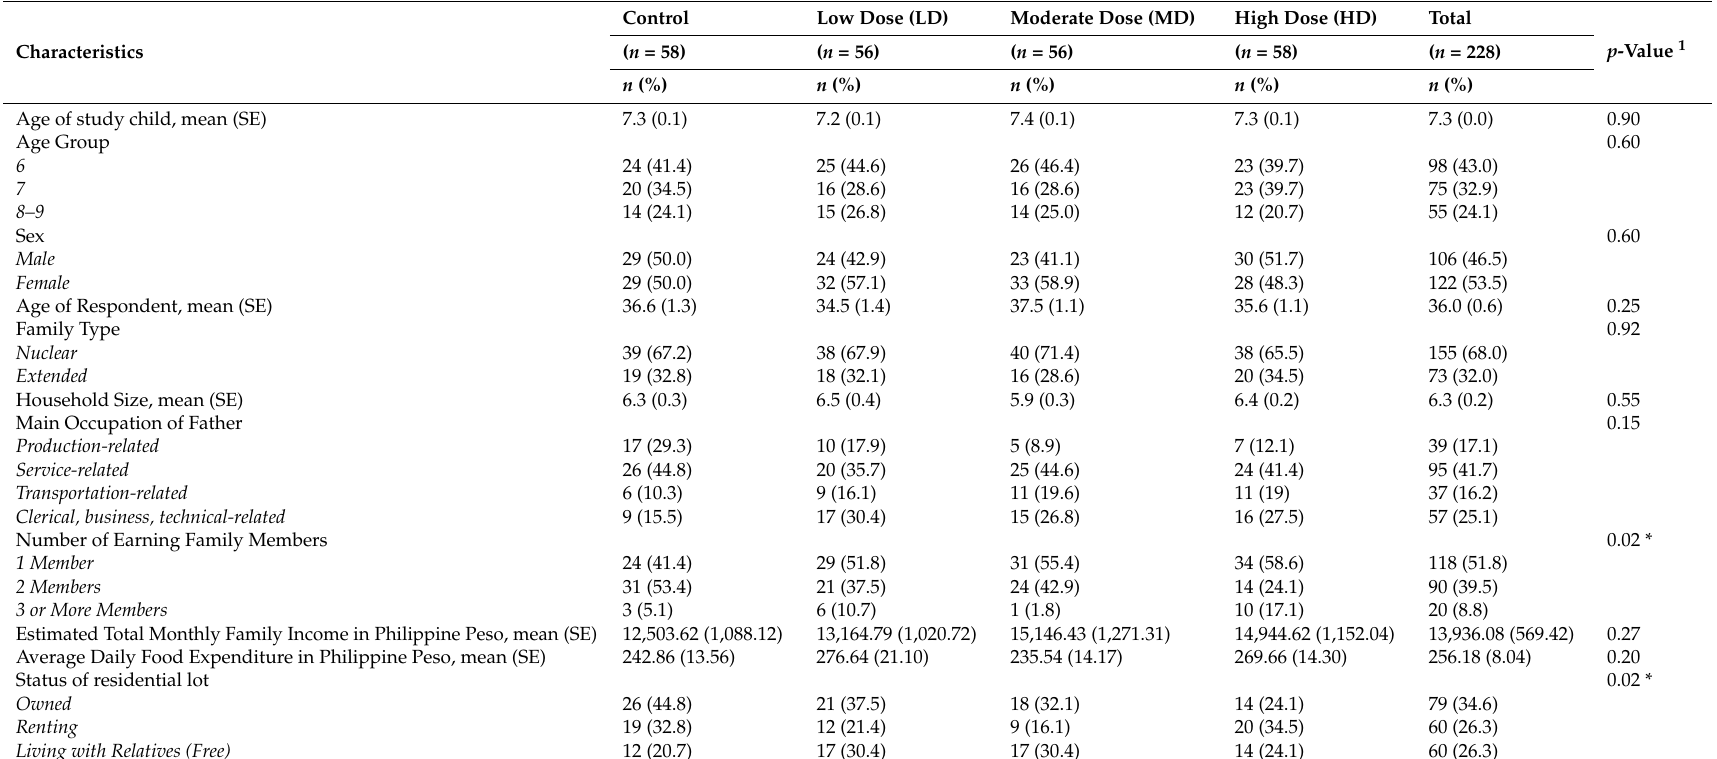
Table 2. Distribution of children by socio-economic and demographic characteristics at baseline by